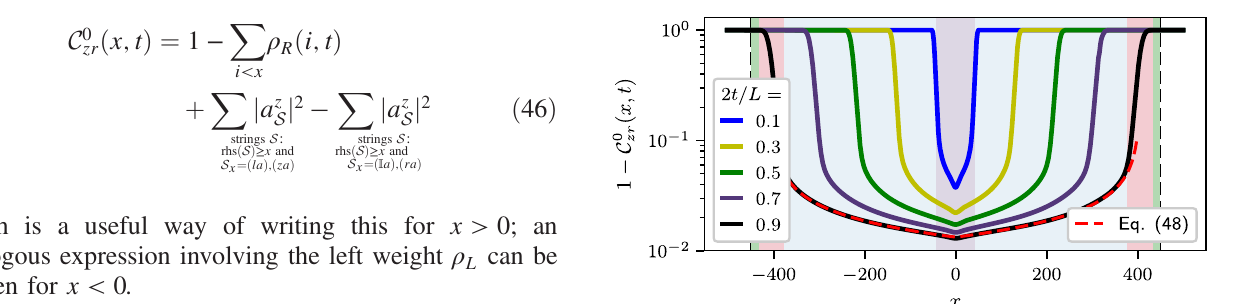
FIG. 5. One minus the out-of-time-order commutator (OTOC) between z 0 ð t Þ and r x at zero chemical potential C 0 zr plotted against x for a system of length L ¼ 1000 at different times t showing the different regimes discussed in the text. For j x j > t (outside the dashed vertical lines), the OTOC is strictly zero due to the locality of the circuit. In the region v B t < j x j < t , which is inside the causal light cone but before the leading front arrives, the OTOC is exponentially small (green shaded area for the latest time). The arrival of the ballistic operator front ( j x j ∼ v B t ) leads to a strong increase in the OTOC from a value exponentially small to an O ð 1 Þ value (shaded red area for the latest time). However, diffusive tails in the operator shape or internal structure lead to diffusive power-law tails in space and time ∼ ð x − v B t Þ − 1 = 2 in the late-time approach of the OTOC to its final value of 1 (shaded blue area for the latest time). By contrast, for an unconstrained random circuit (not shown), the OTOC at a given site approaches one exponentially quickly after the leading front passes [37,38]. ffiffiffiffiffiffiffiffi p D t The diffusive region near the origin j x j ≲ (shaded purple) c receives a subleading 1 =t contribution from the conserved charges which shows up as a “ dimple ” in the curves at early times which becomes weaker at late times. All curves are obtained via a simulation using q ¼ 3 and taking into account all processes to order 1 =q 2 . The dashed red curve is the q ¼ ∞ prediction for the functional form of the tail [Eq.